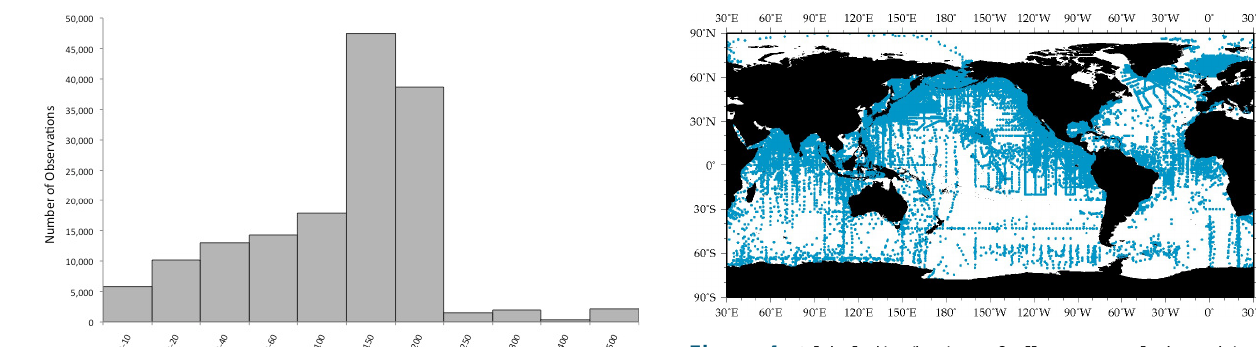
Figure 4. Global distribution of all mesozooplankton biomass data (converted to carbon and a common 333 µ m equivalent mesh size). Each point represents a station where mesozooplankton were